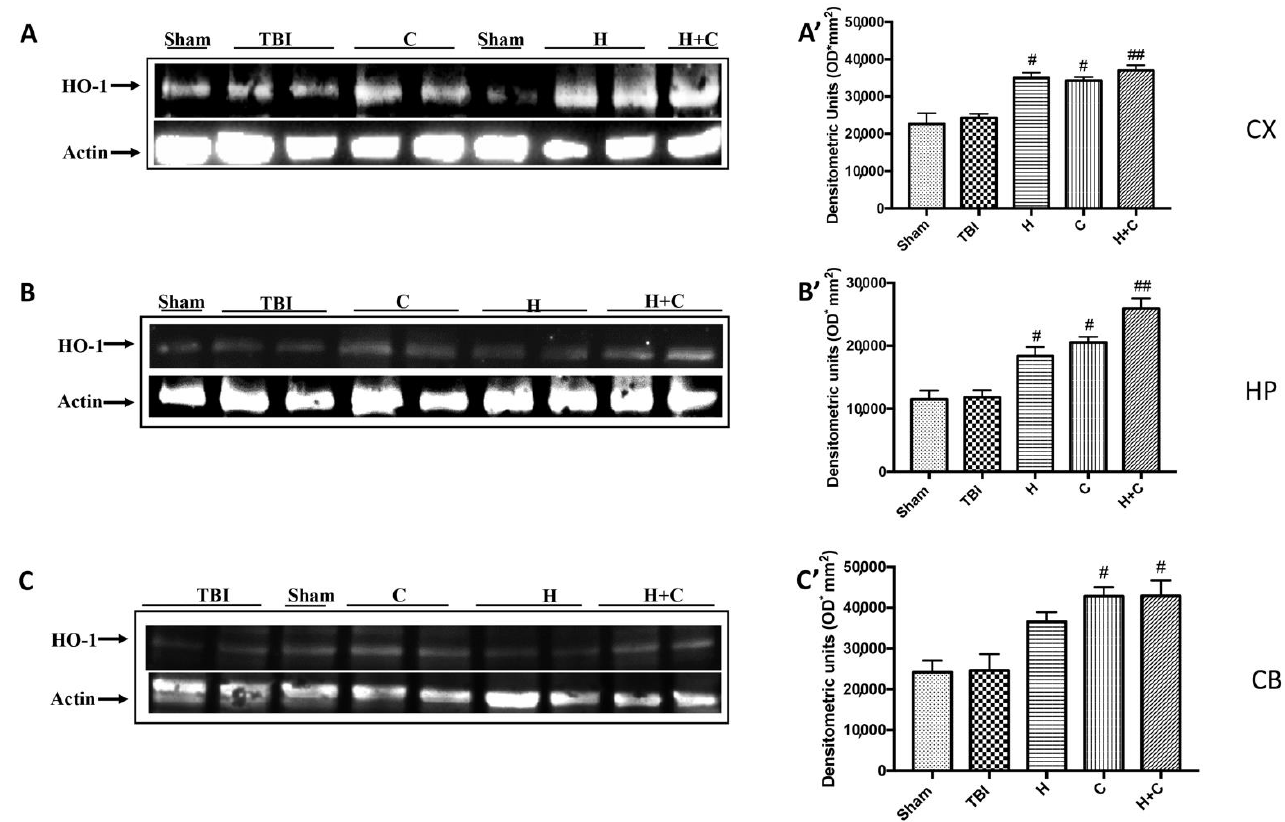
Figure 8. Effect of H. erinaceus or C. versicolor , or H. erinaceus + C. versicolor treatment on HO-1 protein after chronic TBI. Western blot analysis showed that the expression of HO-1 increased insignificantly in the TBI group in CX ( A ), HP ( B ) and CB ( C ) regions. H, C, and H + C treatment further significantly increased the expression of HO-1 ( A – C ). The data are expressed as the mean SEM from n = 5 mice/group. Densitometry analysis: ( A’ ) # p < 0.05 vs. TBI; # p < 0.05 vs. TBI; ## p < 0.01 vs. TBI; ( B’ ) # p < 0.05 vs. TBI; # p < 0.05 vs. TBI; ## p < 0.01 vs. TBI; ( C’ ) # p < 0.05 vs. TBI; # p < 0.05 vs. TBI.